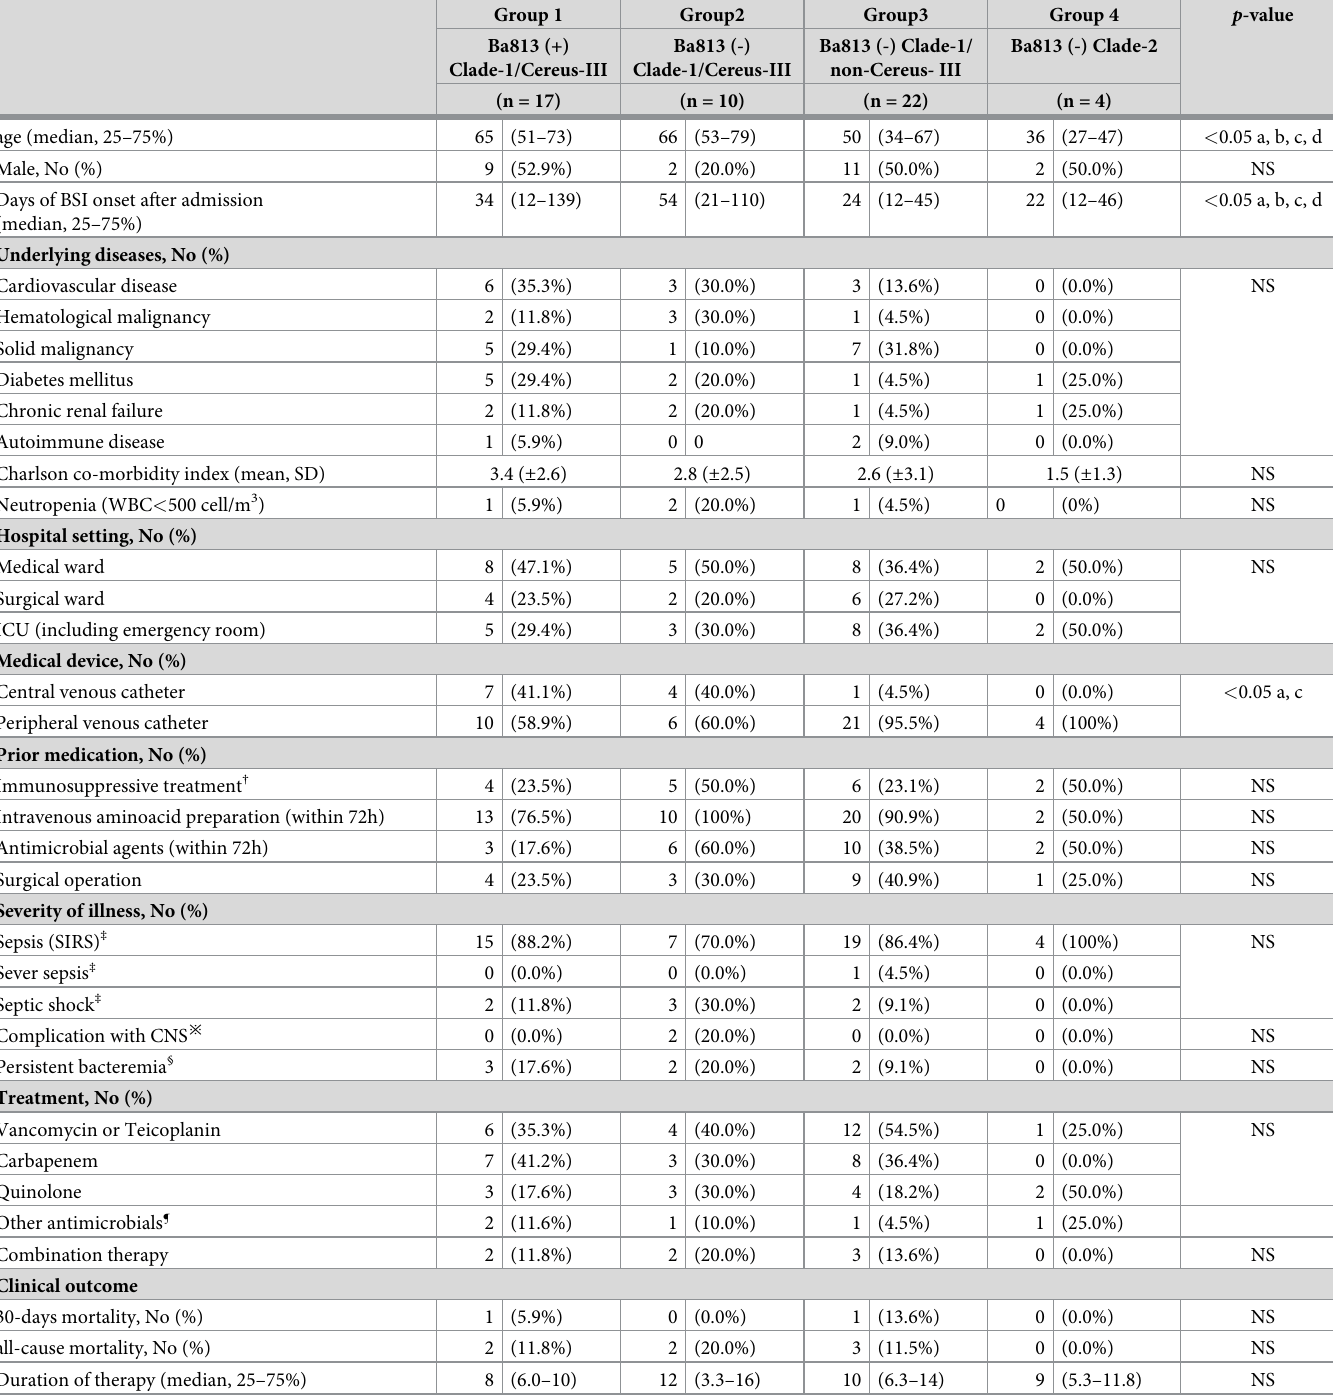
Table 2. Comparison of clinical characteristics and outcome among four groups of B . cereus